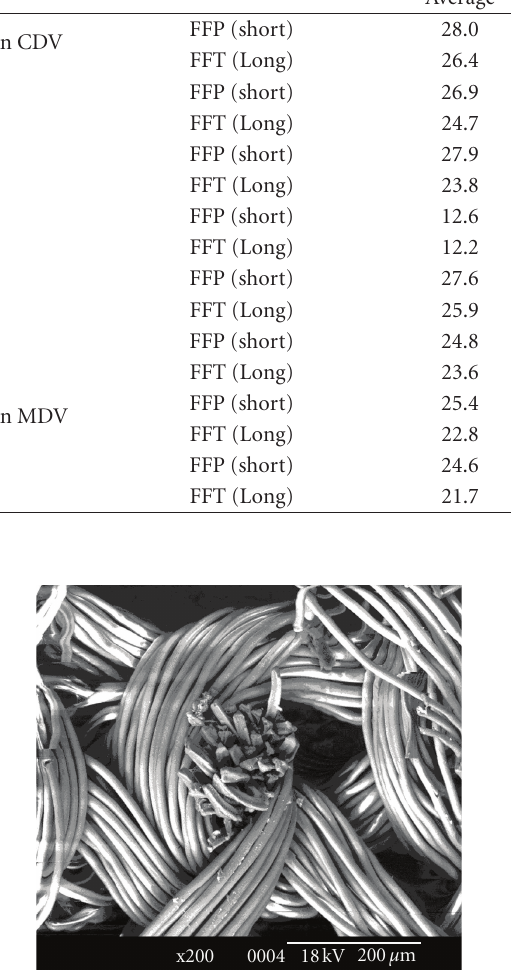
Figure 7: Scanning electron microscopy examination of Cooley Double Velours prosthesis. Transversal breaks of trilobar filament.